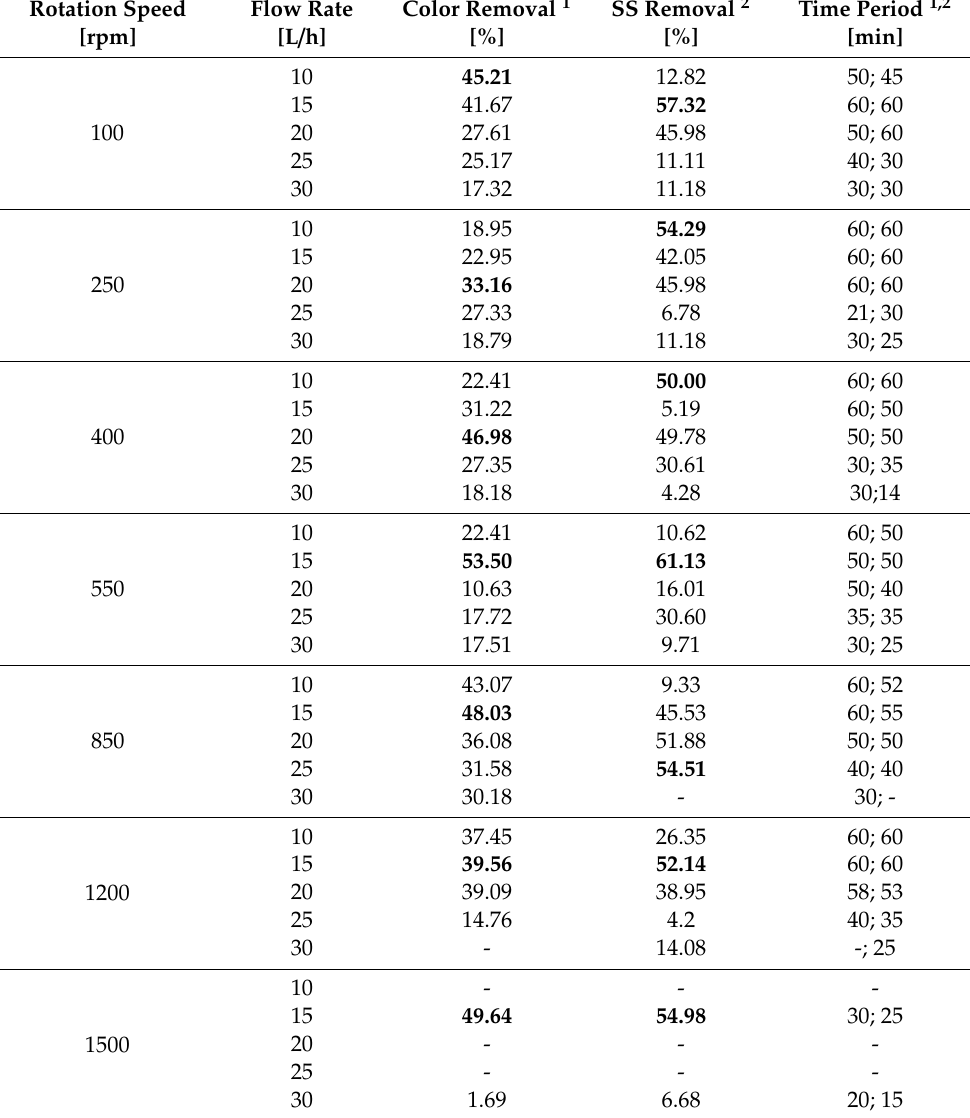
Note: 1 Color removal; 2 SS